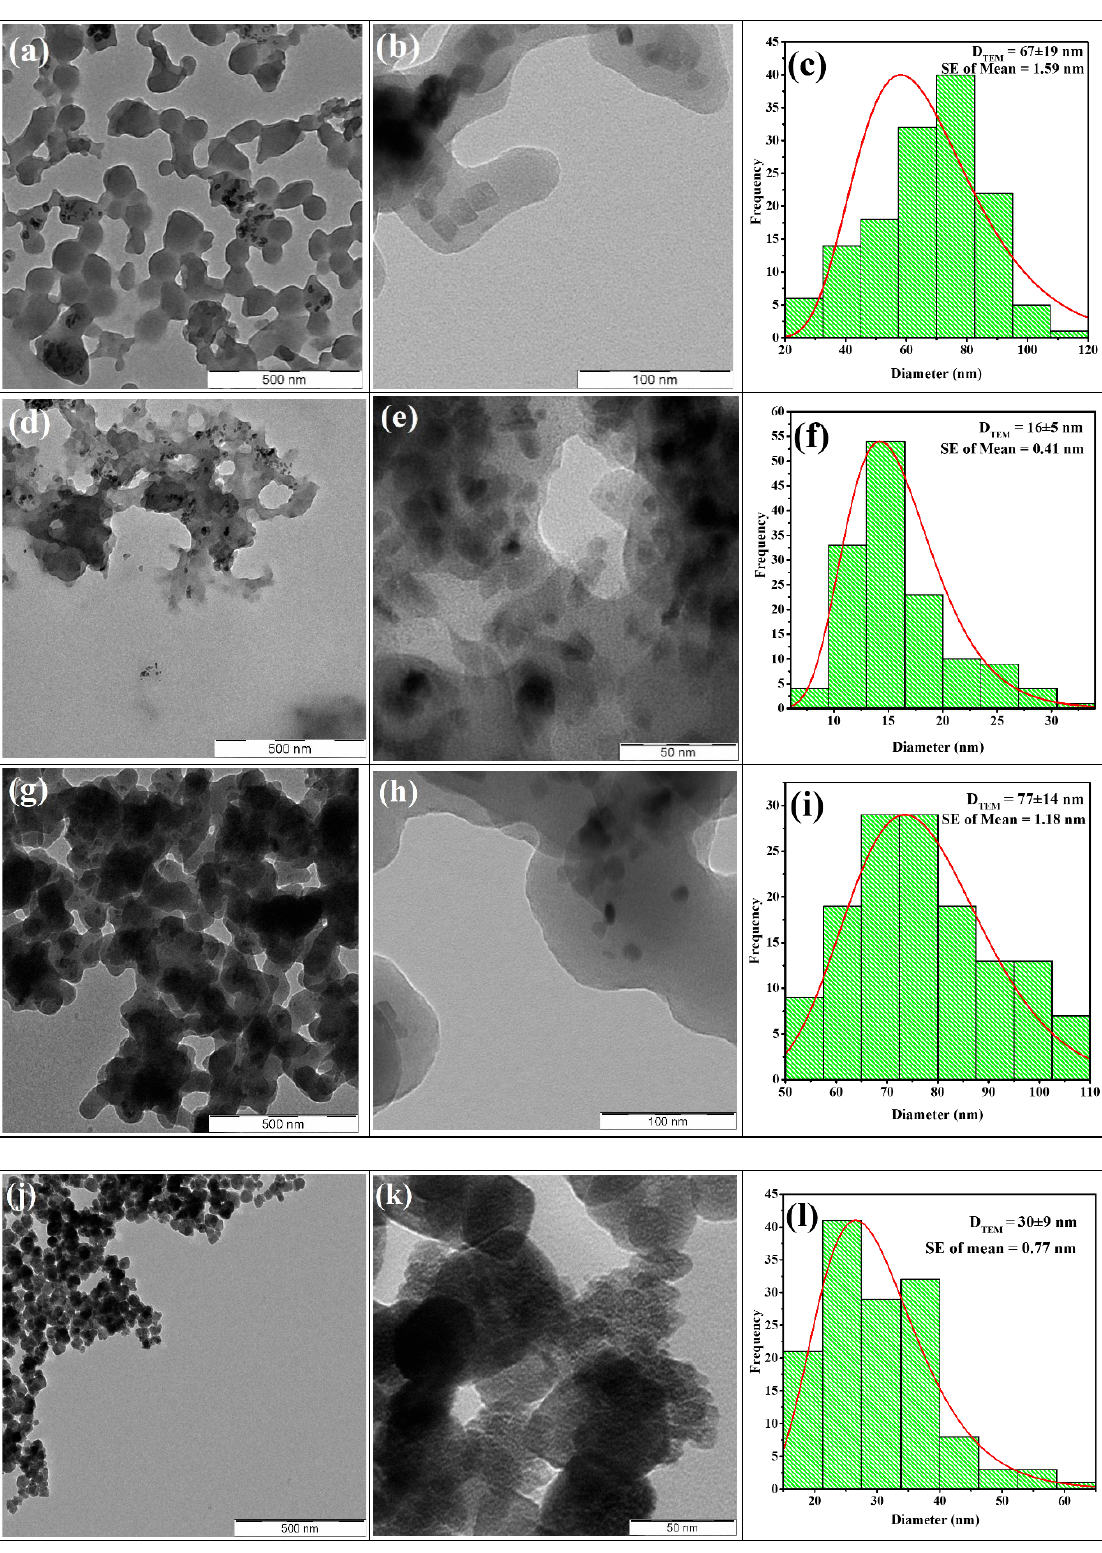
Figure 5. TEM images with different resolutions (12.5 k×, 100 k×) and particle size distributions of Fe 3 O 4 @C-T 190 t 3 ( a – c ), Fe 3 O 4 @C-T 190 t 4 ( d – f ), Fe 3 O 4 @C-T 190 t 5 ( g – i ), and Fe 3 O 4 NPs ( j – l ),